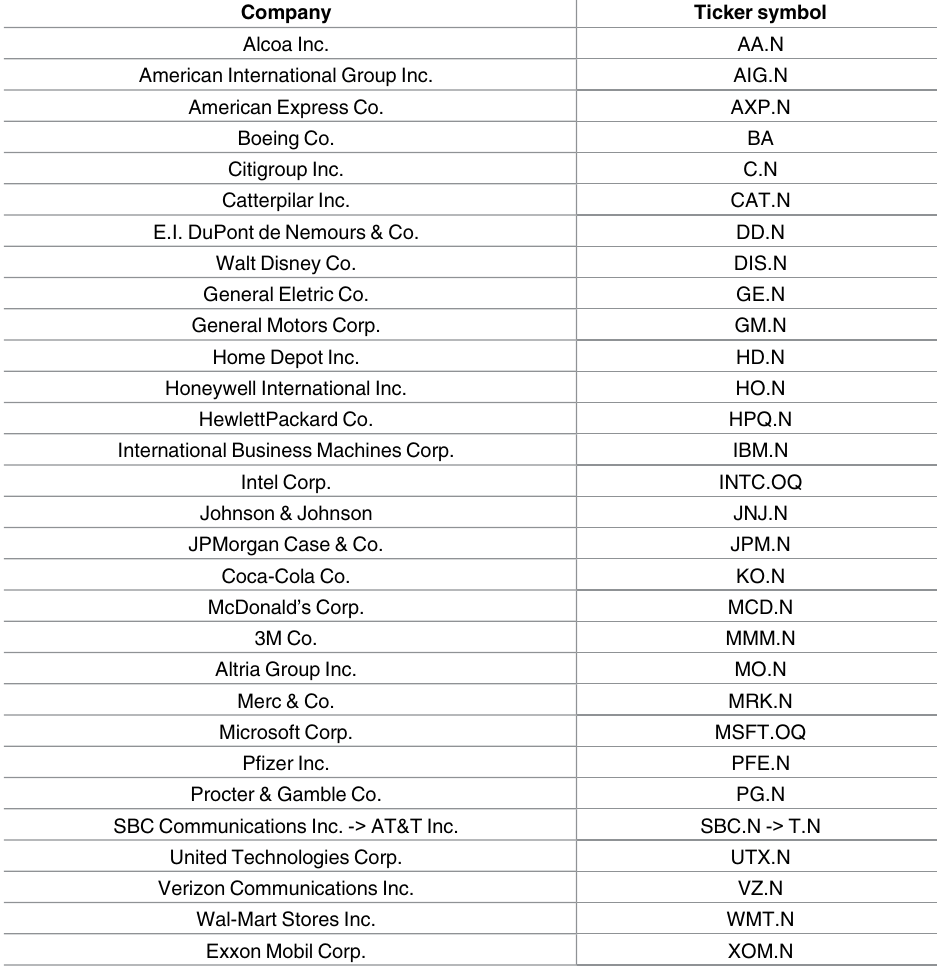
Table 1. Companies analysed and their ticker symbols. Company Ticker symbol Alcoa Inc. AA.N American International Group Inc. AIG.N American Express Co. Boeing